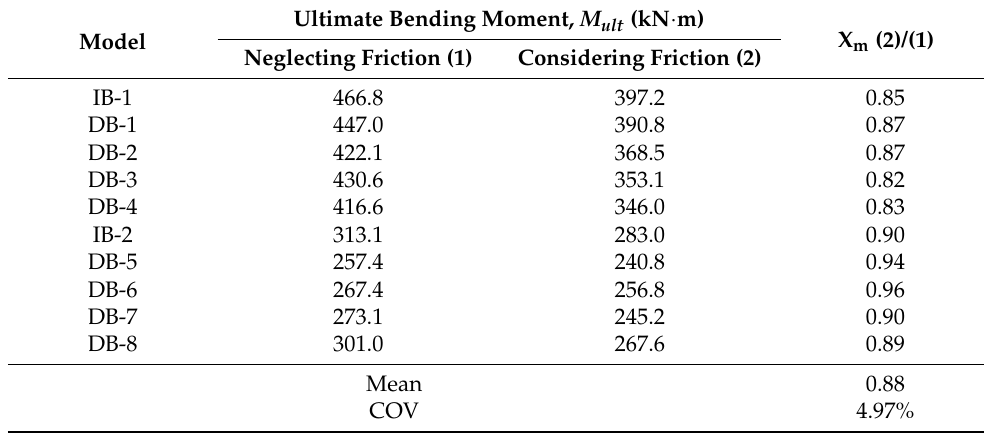
Table 9. Effects of the frictional force on the ultimate bending-moment estimations.